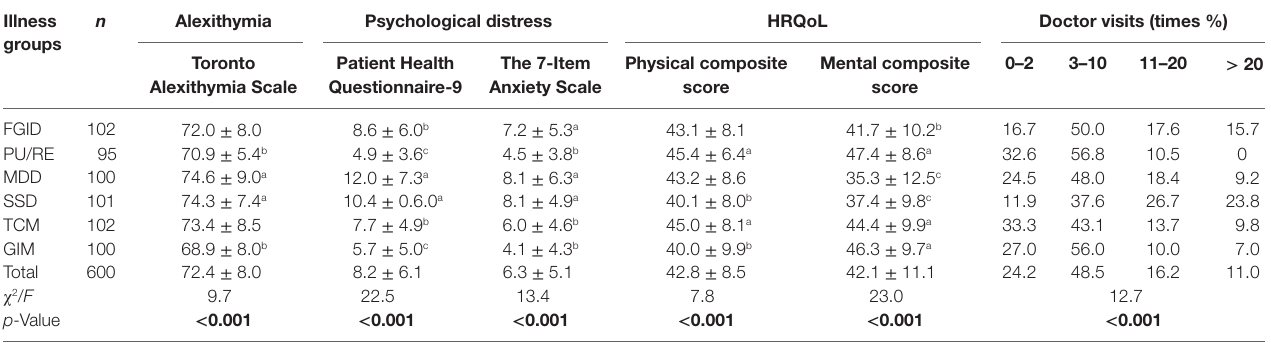
Table 3 | Alexithymia, psychological distress, health-related quality of life (HRQoL), and doctor visits in the past 12 months of six illness groups of participants ( n =